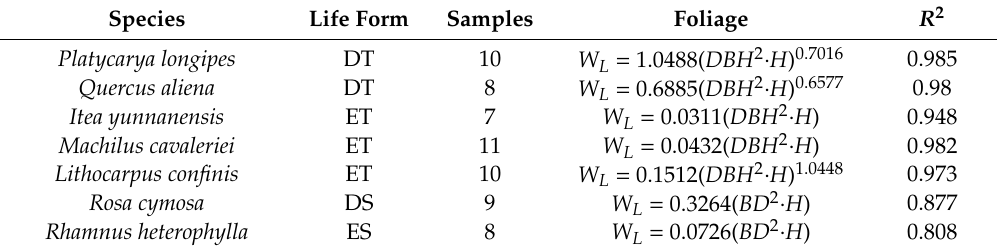
Table 2. Allometric regression equations (foliage) for the most typical biomass in the karst study area, southwest China [21]. DT (Dedicous tree); ET (Evergreen tree); DS (Deciduous Shrub). W L , W W , DBH, BD, H are biomass of leaf (g), diameter at breast height (mm), basal diameter (mm) and height (m), respectively.